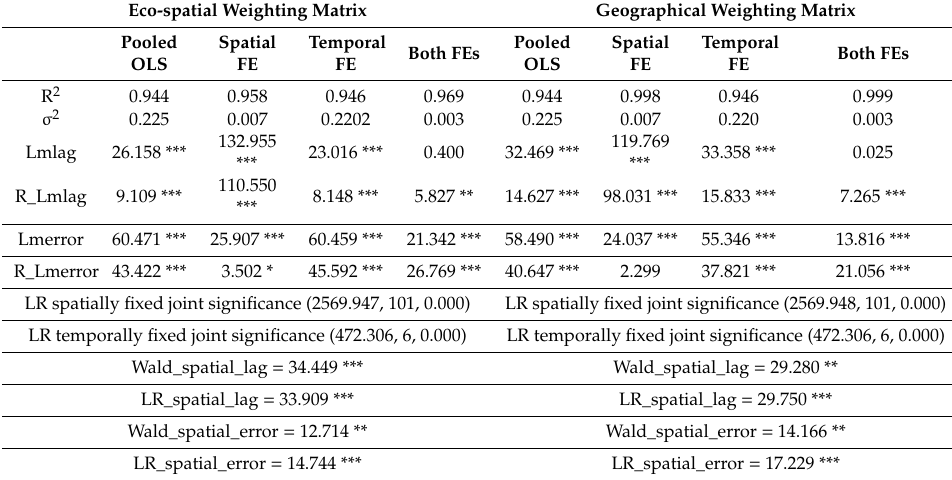
Table 2. Estimation results without spatial interactive e ff